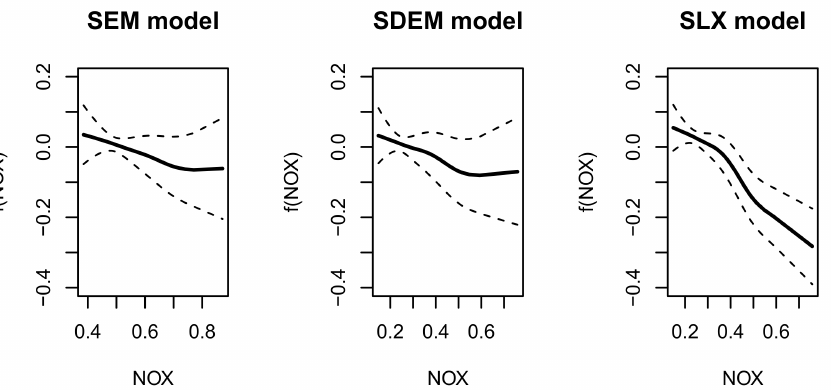
Figure 3. Smoothed effects of nitric oxide concentration (NOX) for three spatial econometrics models with 95% credible